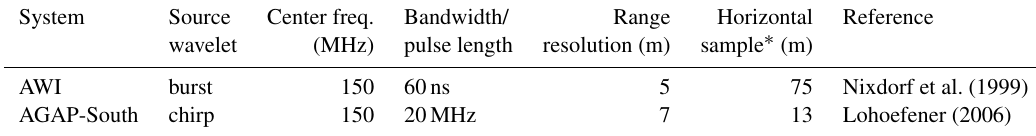
Table 1. Characteristics of the two RES systems. Range resolution and horizontal sampling distance are given for the processed data. System